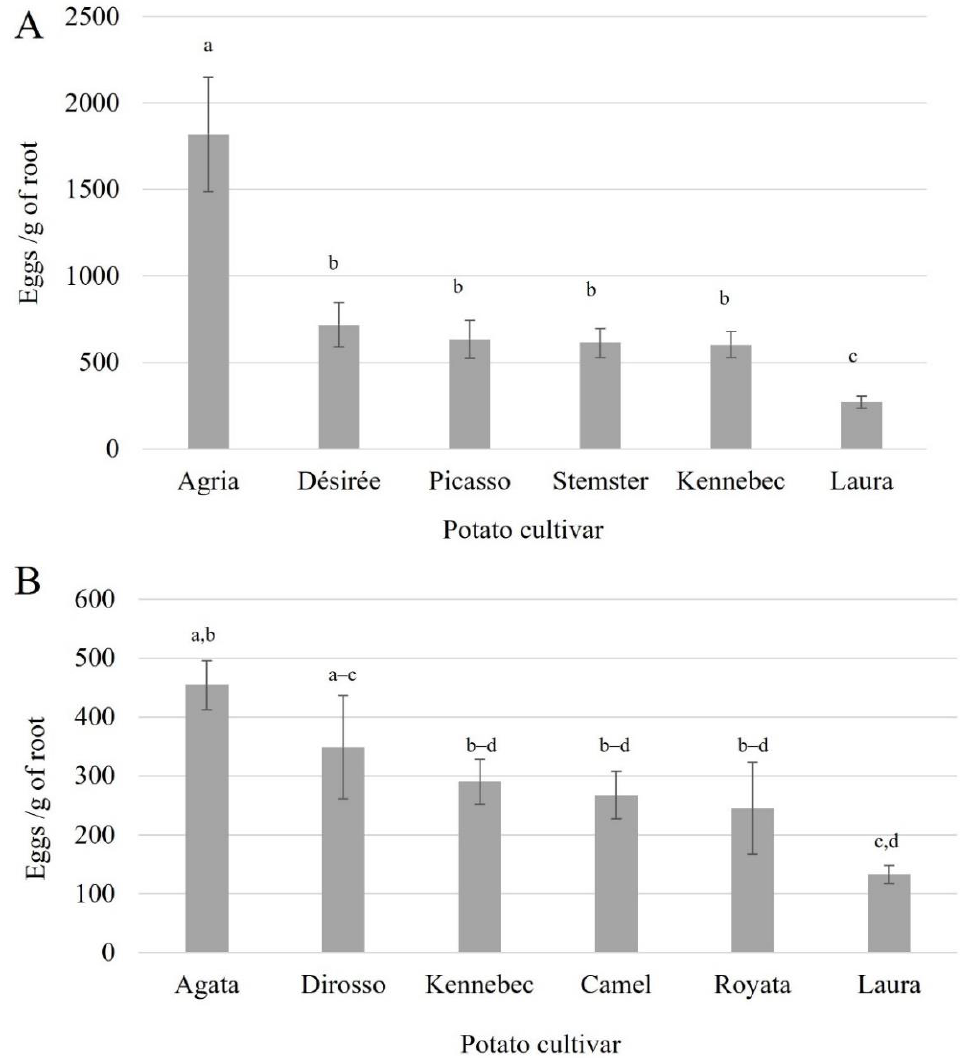
Figure 8. Eggs/g of root of on potato, Solanum tuberosum , cultivars: ( A ) Agria, Désirée, Picasso, Stemster, Kennebc, and Laura (Assay 1); ( B ) Agata, Dirosso, Kennebec, Camel, Royata, and Laura (Assay 2), 60 days after inoculation with 8000 Pratylenchus penetrans mixed stages. Data are the means of six replicates ± standard error. Means followed by different combination of letters differ significantly at p < 0.05, according to the Fisher LSD test.